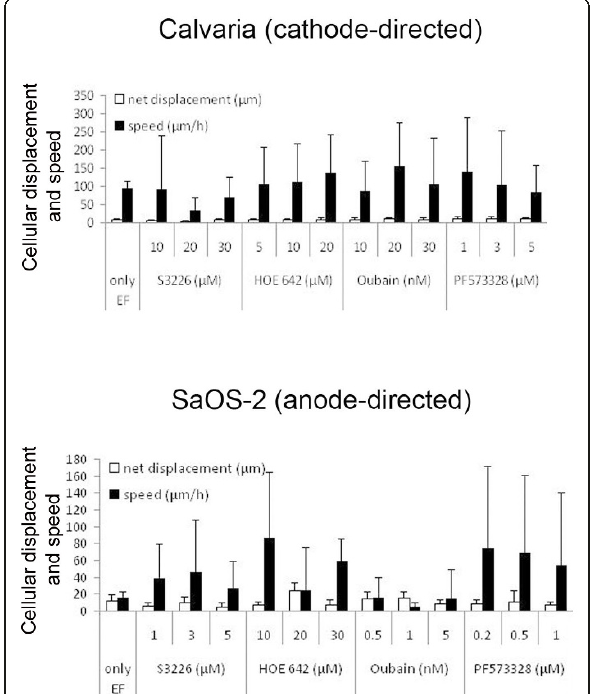
Figure 4 The speed ( μ m/h) and net linear displacement ( μ m) of cathode (Calvaria)- or anode (SaOS-2)-directed cells in the presence of an applied EF or, an EF in combination with the NHE3-, NHE1-, or NaKA-specific inhibitors, S3226, HOE 642, or Oubain, respectively . Error bars represent the SEM for 25-45 cells from three to five separate